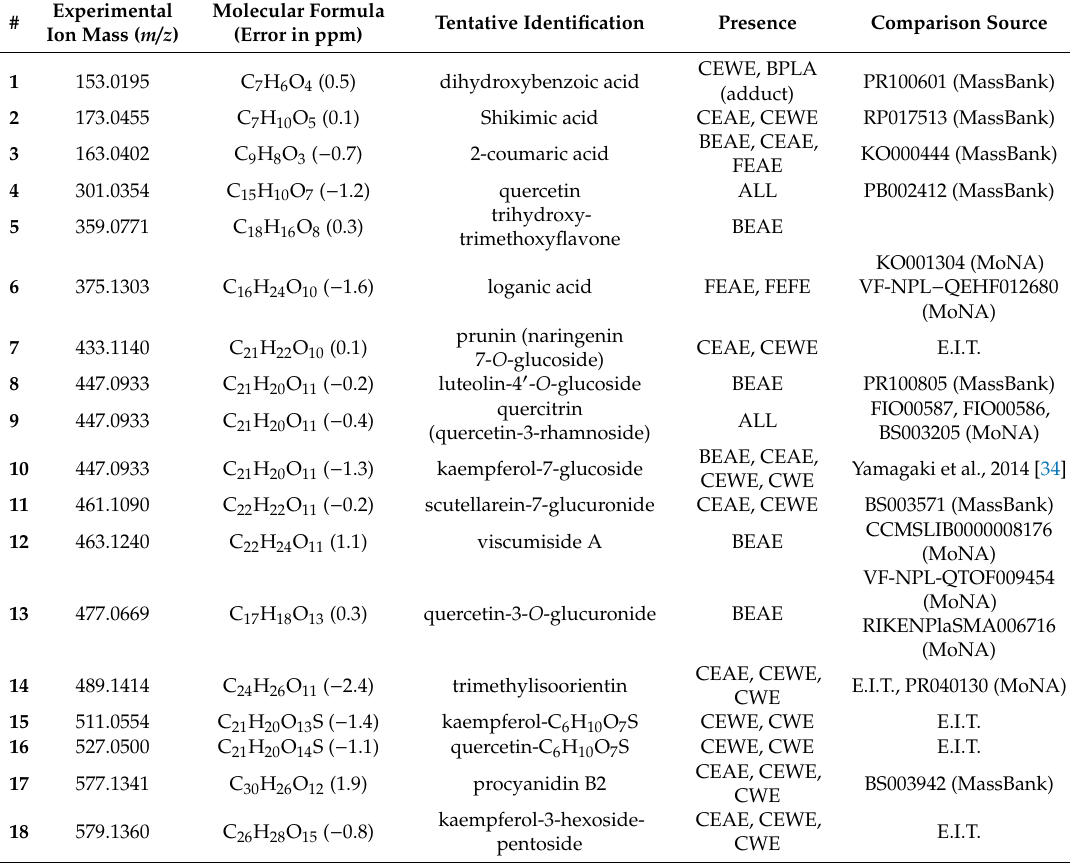
Table 1. LC-MS / MS details of compounds detected in extracts and analyzed at 40 eV in negative ion